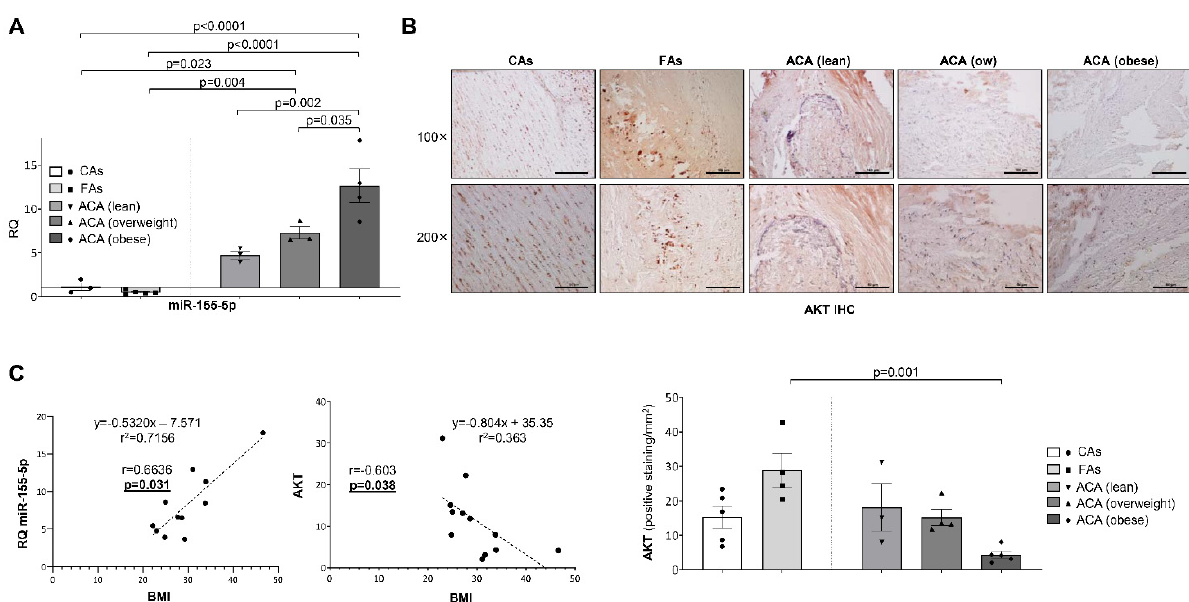
Figure 5. miR-155-5p and AKT expression correlated with the body mass index in human samples. ( A ) Expression levels of miR-155-5p in human carotid samples of patients stratified according to the Body Mass Index criteria of the World Health Organization. ( B ) Representative images of AKT immunohistochemistry ( upper ) and their quantification ( lower ) in human samples of patients stratified according to the Body Mass Index criteria of the World Health Organization. Magnification 100× (scale bar = 100 µm); magnification 200× (scale bar = 50 µm). ( C ) Scatter plots and Spearman’s r correlations between the Body Mass Index and miR-155-5p expression ( left ) or AKT expression ( right ). AKT = protein kinase B; FAs = fibrolipidic plaque; ACA = advanced carotid atherosclerotic plaque; ow = overweight; IHC = immunohistochemistry; BMI = body mass index. miR-155-5p qPCR: CAs ( n = 3); FAs ( n = 5); ACA (lean) ( n = 3); ACA (overweight) ( n = 3); ACA (obese) ( n = 4). AKT immunohistochemistry: CAs ( n = 5); FAs ( n = 4); ACA (lean) ( n = 3); ACA (overweight) ( n = 4); ACA (obese) ( n = 5). Correlation between miR-155-5p and BMI ( n = 11) and between AKT and BMI ( n = 12).